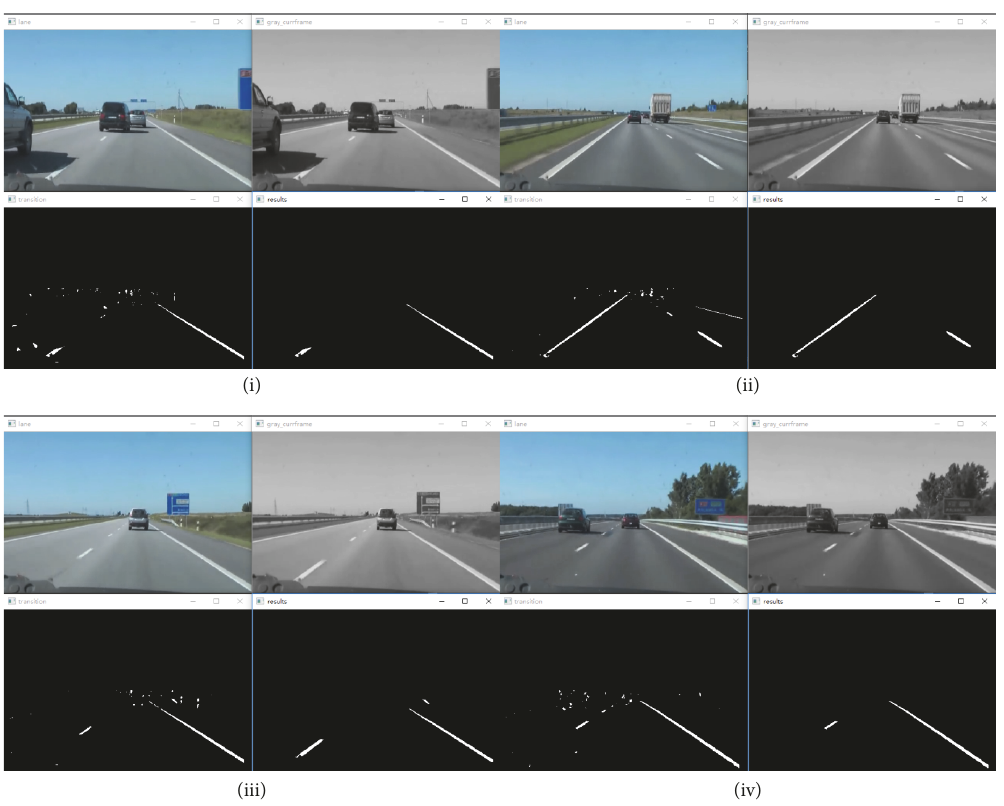
Figure 13: Different moments (i), (ii), (iii), and (iv) in one